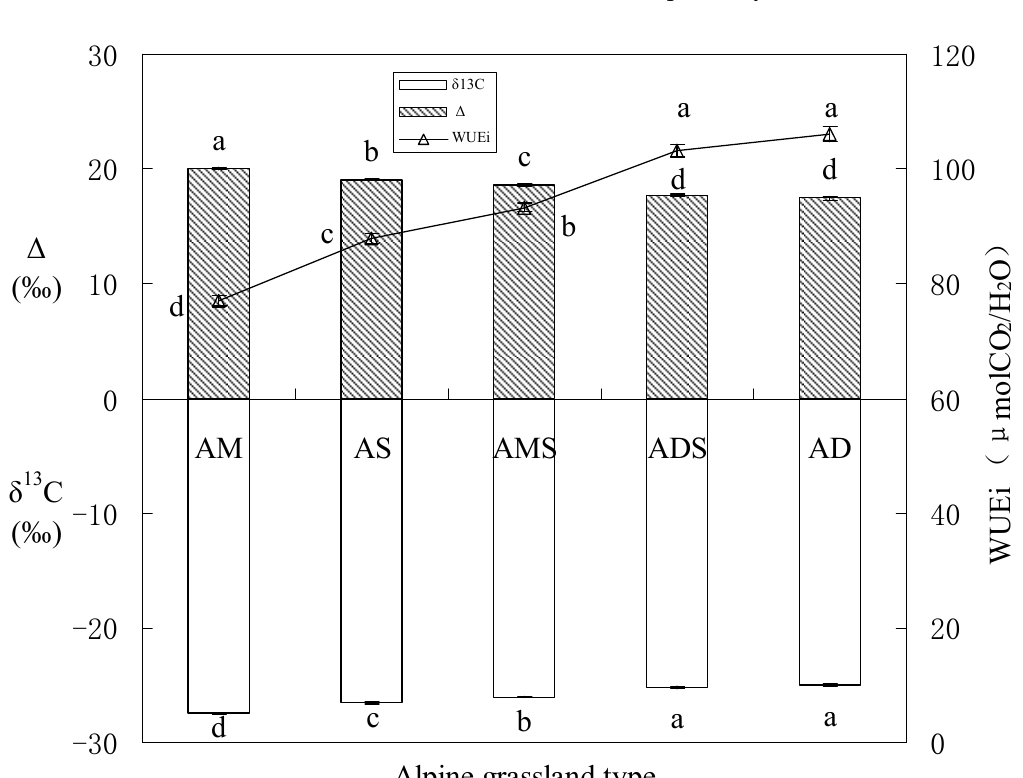
Figure 4. The δ 13 C , Carbon isotope discrimination ( ∆ ) and intrinsic water use efficiency (WUEi) of aboveground biomass (AGB) in 5 alpine grassland types. Letters are reported only for significant differences in one-way ANOVA post hoc Tukey’s HSD.